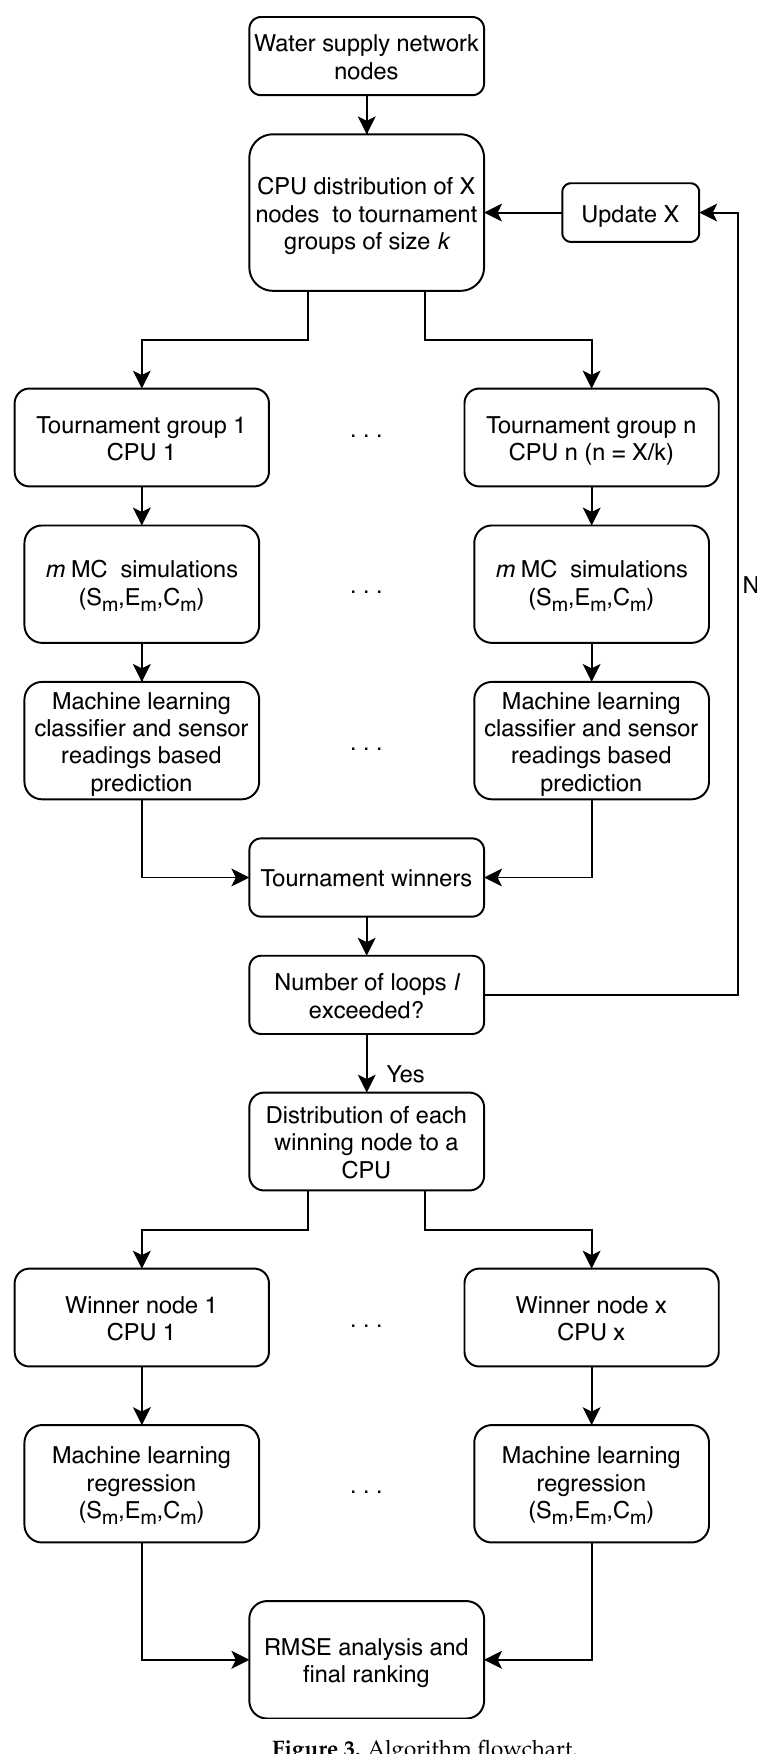
Figure 3. Algorithm